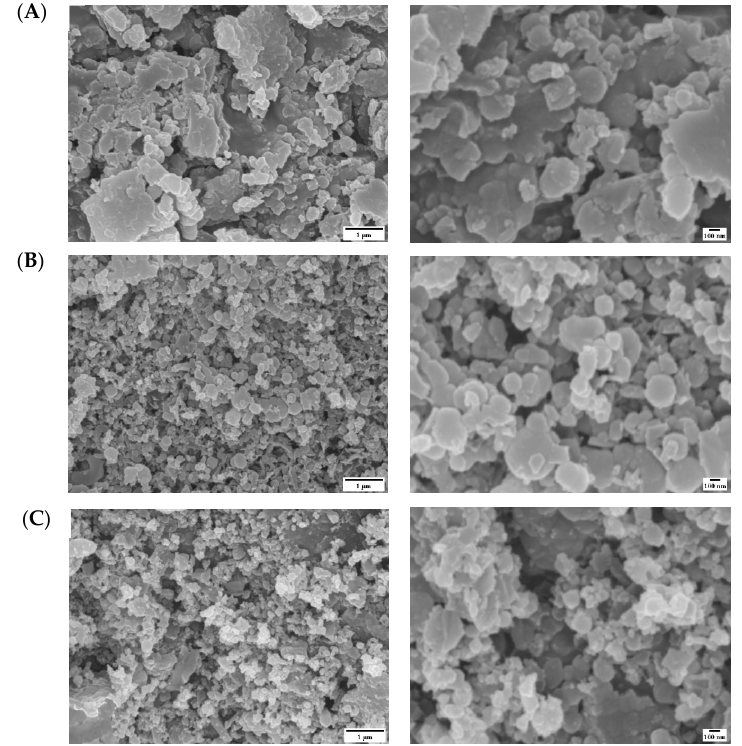
Figure 4. SEM images for ( A ) sample as prepared. ( B ) Sample aged under no MF. ( C ) Sample aged under MF for 1 month at room temperature. Right side indicates low magnification and left side high magnification.